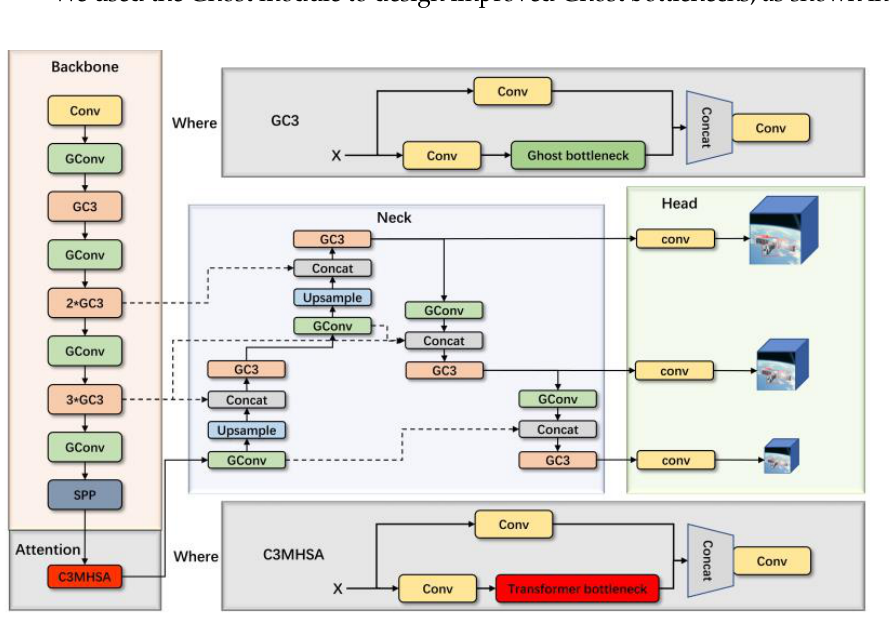
Figure 4. Detection algorithm structural diagram.